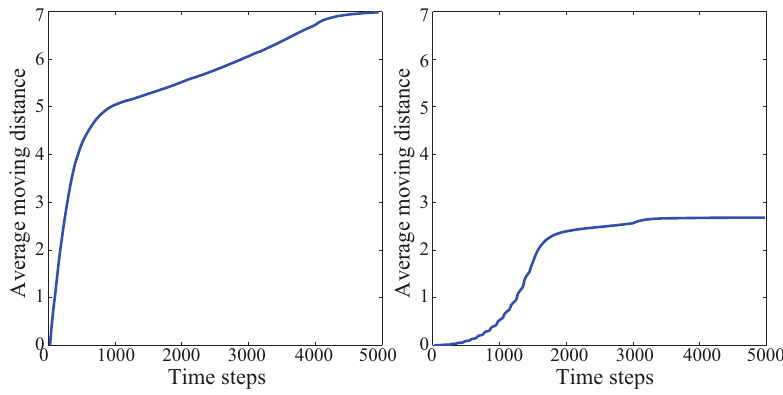
Figure 11. Moving distance from VFA-SF ( left ) and VFA-SF-OPT ( right ). Table 2. The maximum distance, minimum distance, average distance and mean square error of one sensor node in VFA-SF and VFA-SF-OPT for different time